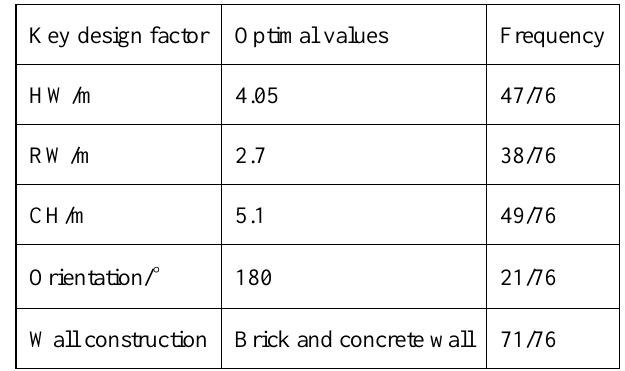
Table 8. The parameters for the optimal climate-responsive design